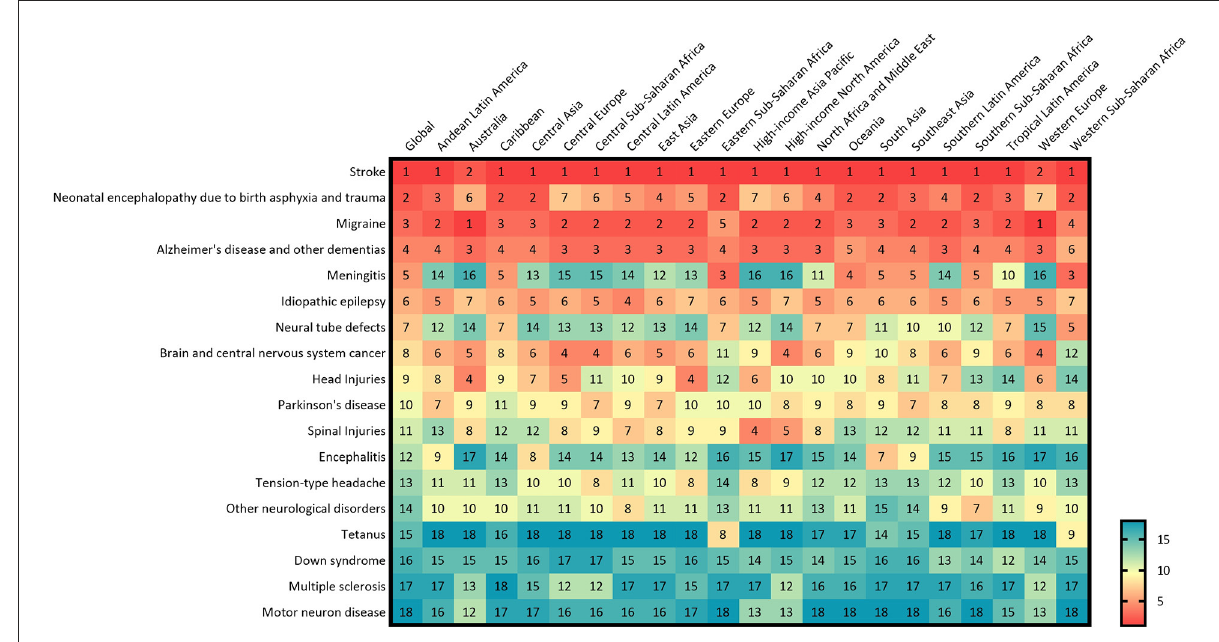
FIGURE3 Ranking of age-standardized DALY rates for neurological disorders by 21 GBD regions, for both sexes, 2019.